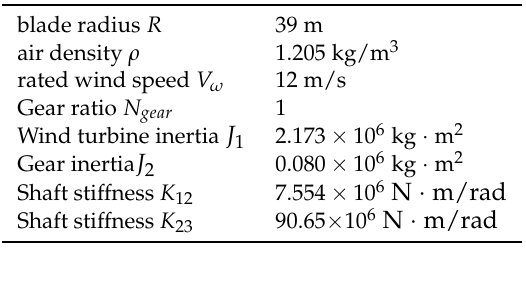
Table 2. Wind turbine parameters.